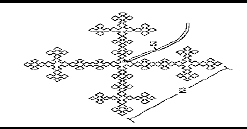
Figure 1: Antenna: a space filling curve called Minkowski Island